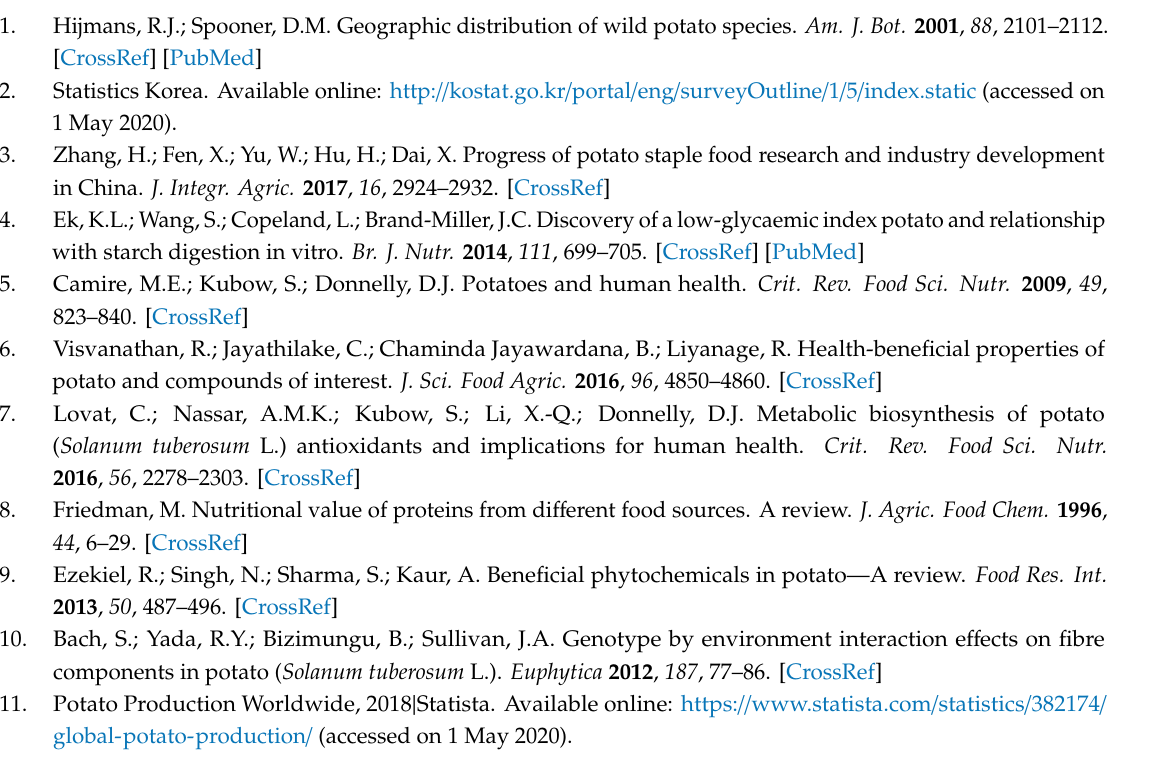
Table S1: Soil condition at R1 (Chuncheon), R2 (Yang-gu) and R3 (Pyeong-chang), Figure S1: Mean temperature, rainfall, and hour of sunshine at Chun-cheon (the top), Yang-gu (the middle), and Pyeong-chang (the bottom) from 2016 to 2018 growing